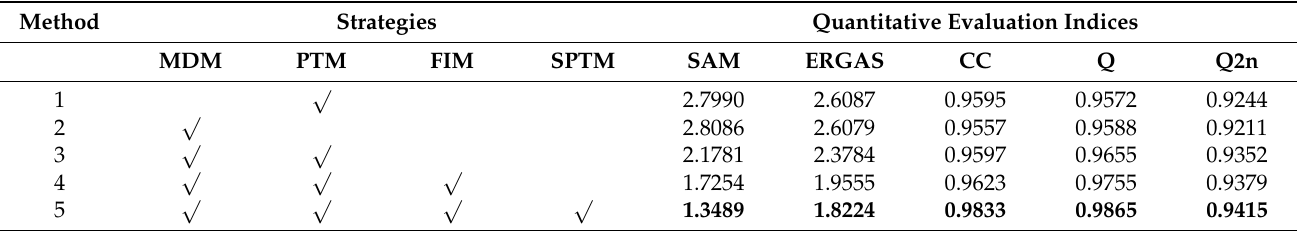
Table 3. Quantitative evaluation comparison of the ablation experiments using the GaoFen-2